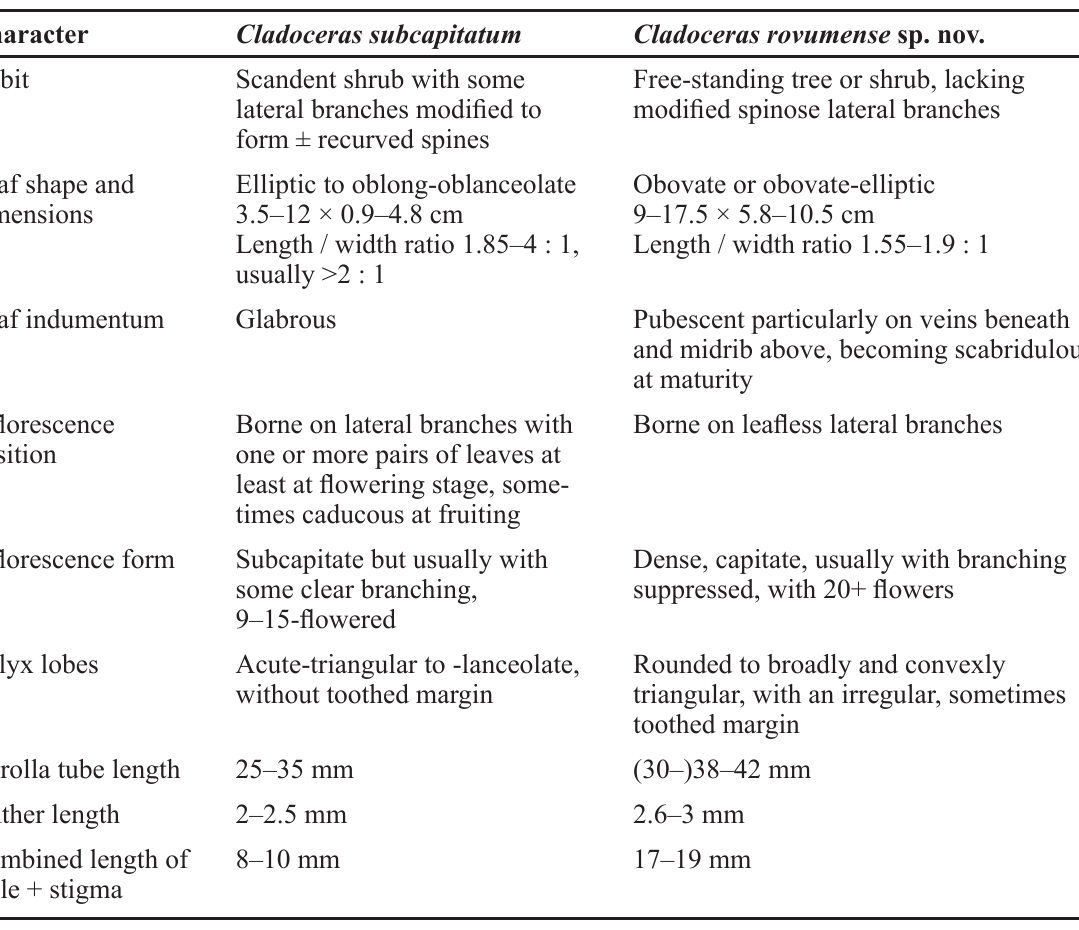
Table 1. The main morphological differences between Cladoceras subcapitatum (K.Schum. &